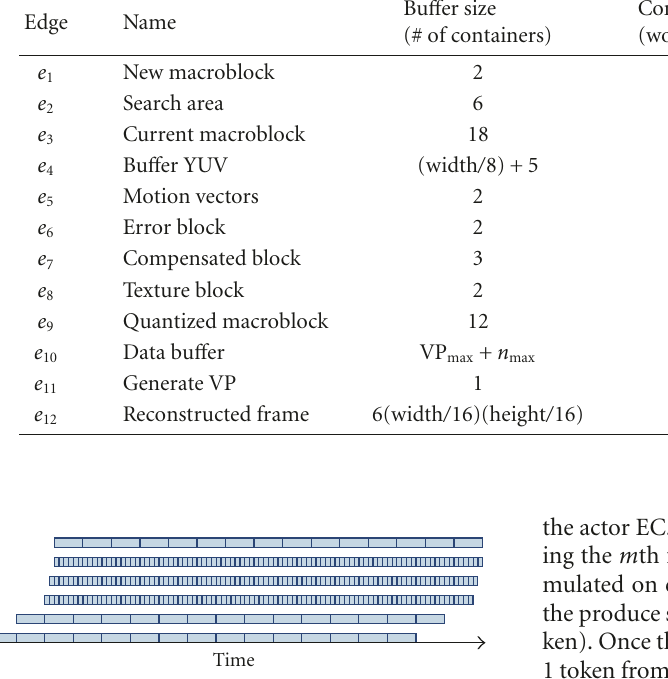
Figure 13: MPEG-4 part 2 SP encoder desired schedule with pipelined parallel operation for one frame with resolution of 80 × 48